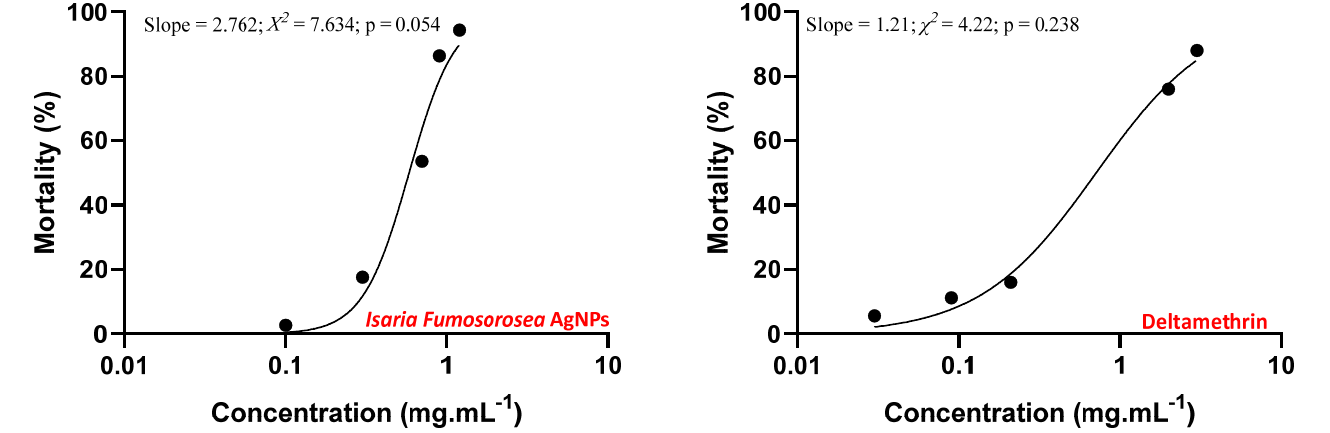
Figure 9. Probit curve of Plutella xylostella exposed to silver nanoparticles synthesized with the en-